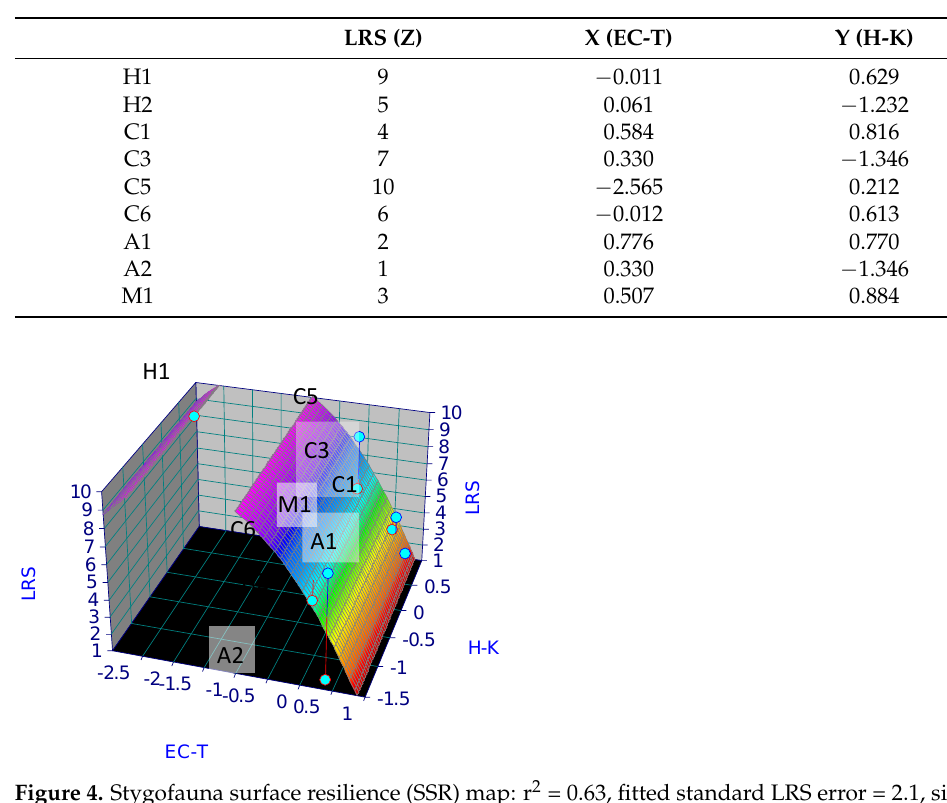
Table 3. Species conservation scores ( Z ) owing to different functional adaptive traits in the same